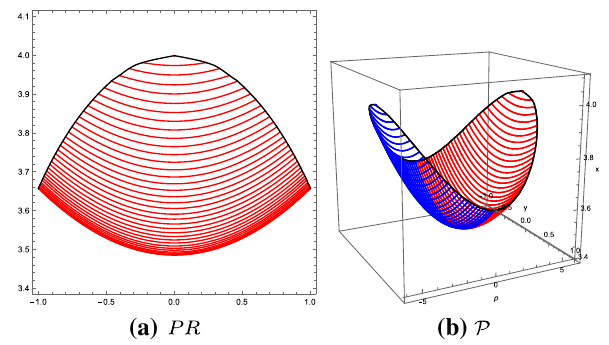
Fig. 3 PR and P in the Zipoy-Voorhees metric ( M = 1, δ =